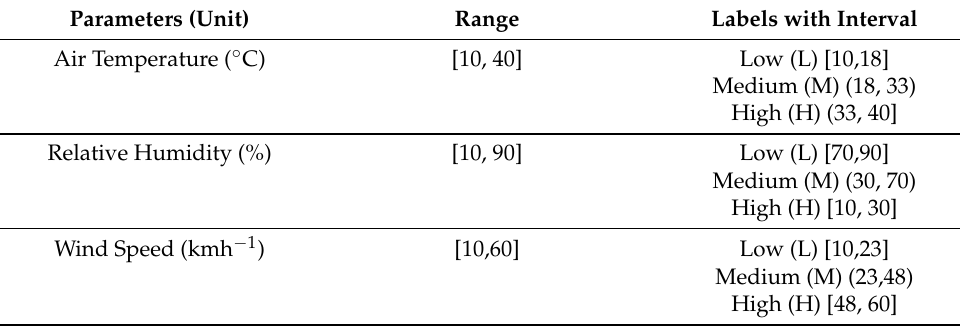
Table 1. Range and discretization of the factors for fire weather.